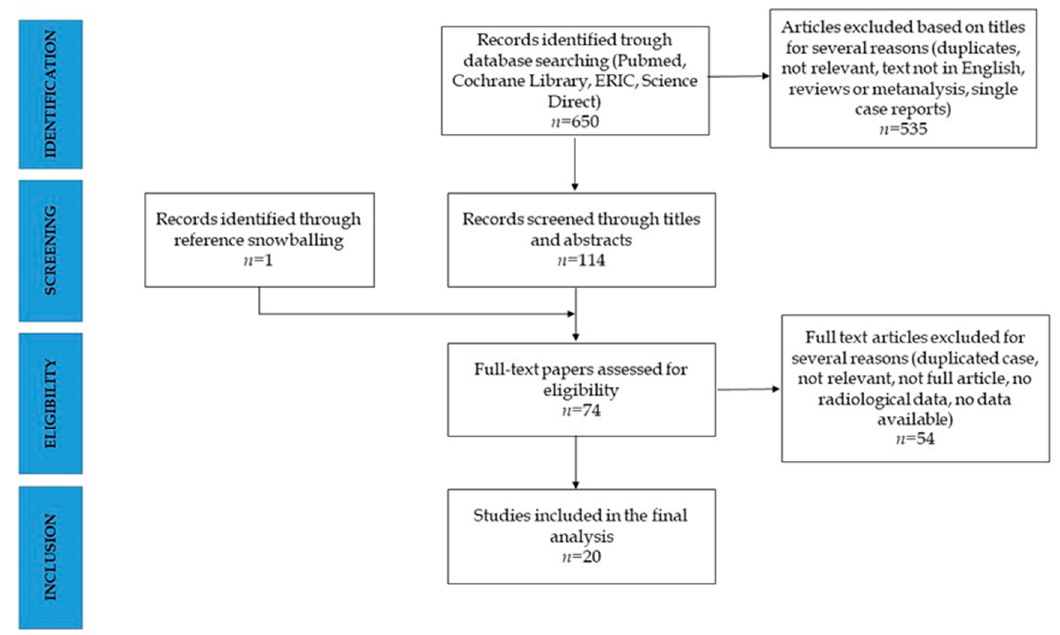
Figure 1. PRISMA diagram for the systematic search.